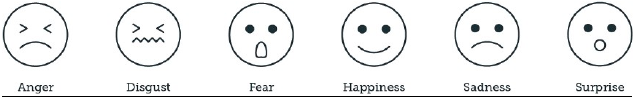
Figure 1. Graphics of the six basic facial expressions (collection one) [46].